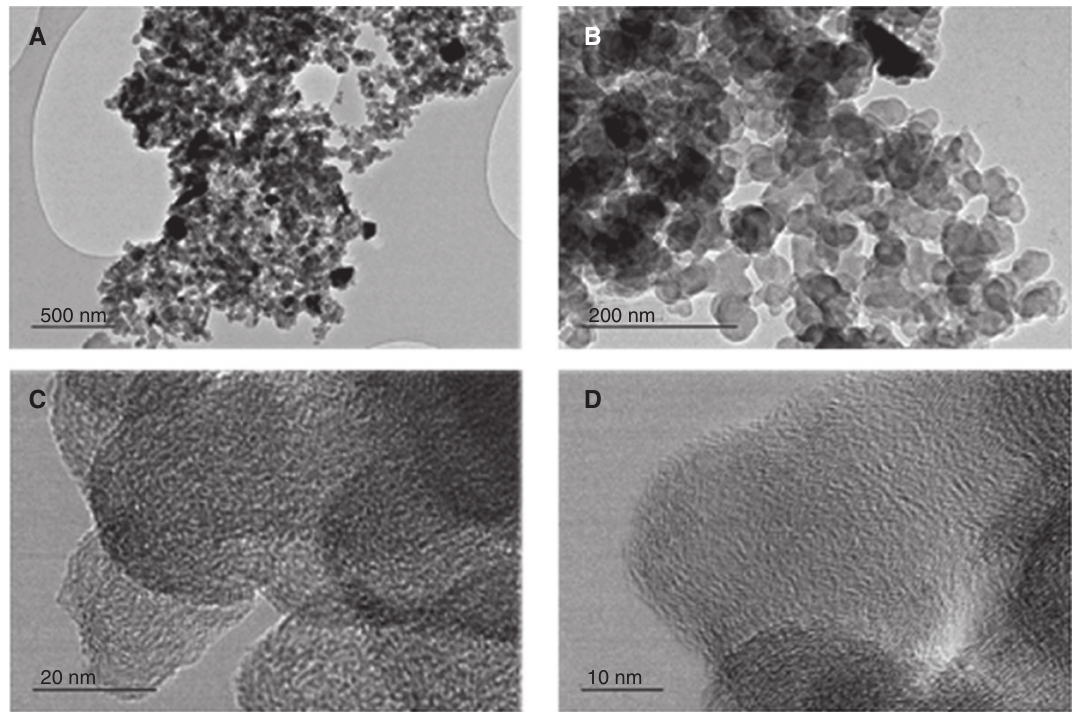
Figure 7: Bright field TEM images at different magnifications (A–D). (A) × 10,000; (B) × 25,000; (C) × 250,000; (D) × 500,000.